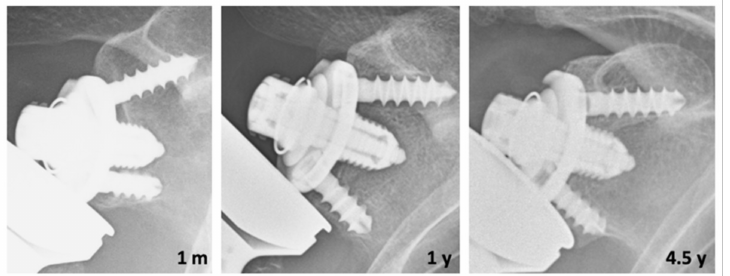
Figure 3. Subsidence of the glenoid due to incomplete glenoid preparation (baseplate not completely in contact with subchondral bone) which stabilizes at last follow-up in high glenoid position with the development of grade 2 scapular notching. m, months; y, year.